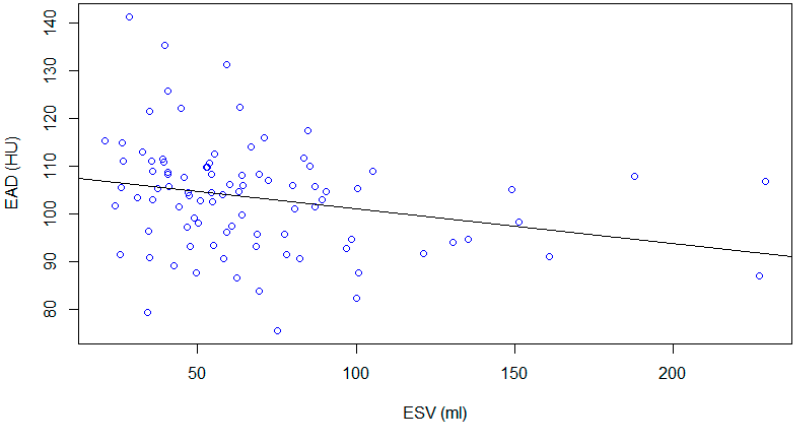
Figure 5. ESV values plotted with EAD. A negative, weak correlation was found (r = − 0.25, r 2 = 0.08, p -value < 0.01) .